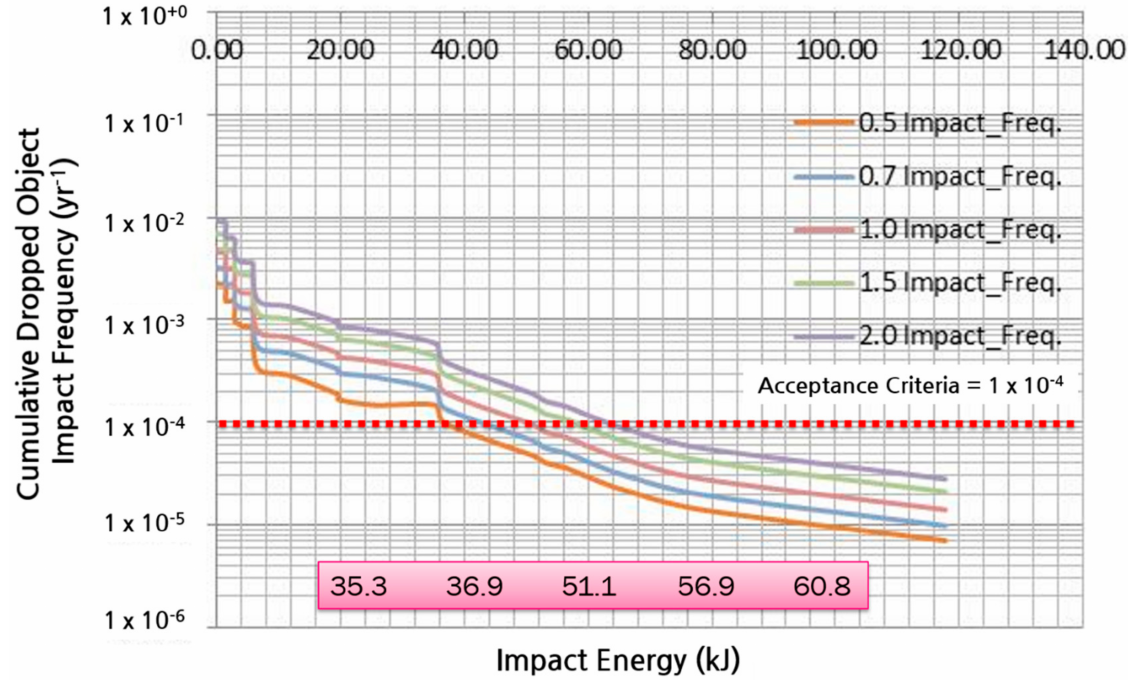
Figure 10. Impact energy exceedance curve by impact frequency.